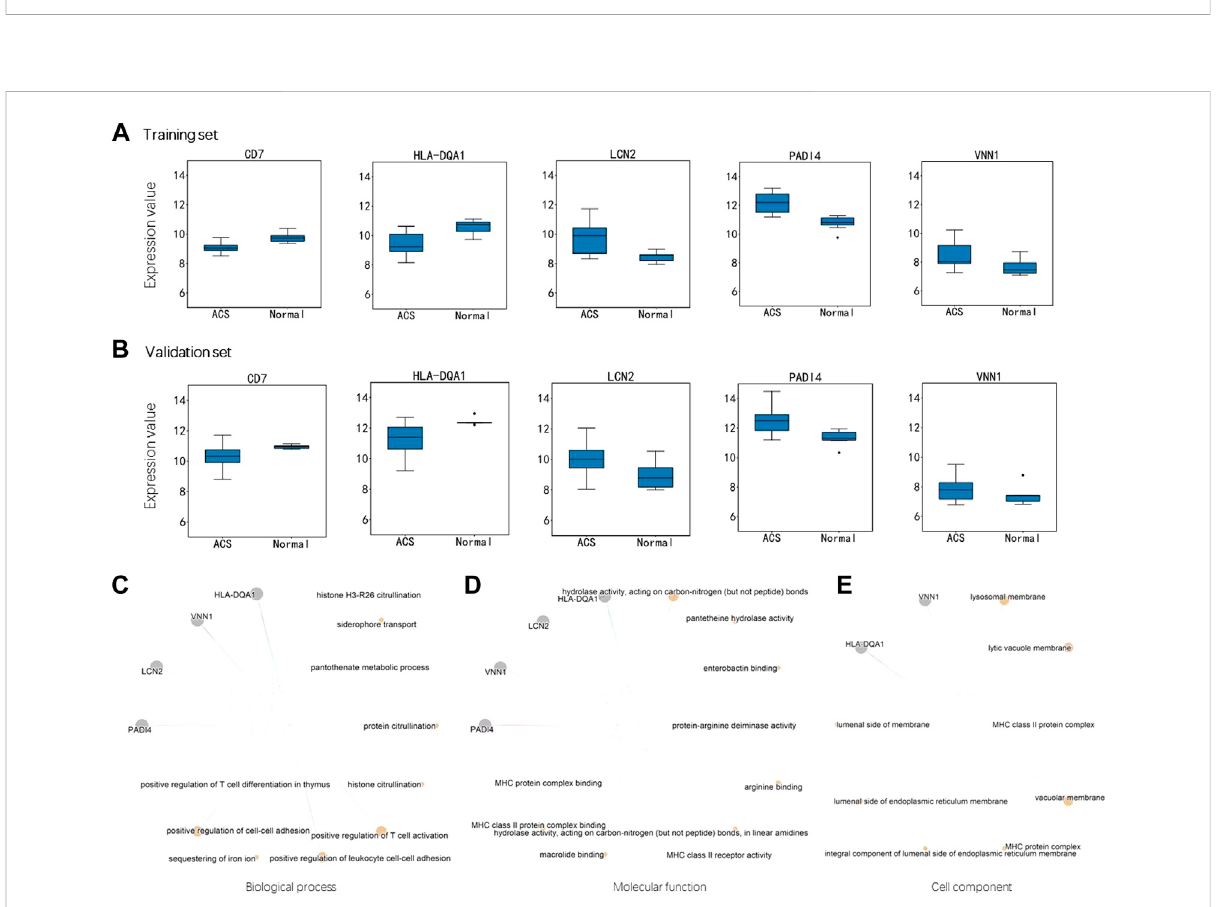
FIGURE 5 ExpressiondifferenceofthegenesinmiSig (A) Expressiondifferenceofthegenesinthetrainingset. (B) Expressiondifferenceofthegenesinthe validation set. Enriched functions of the miSig genes in the ontology of Biological Process (C) , Molecular Function (D) , and Cell component (E)